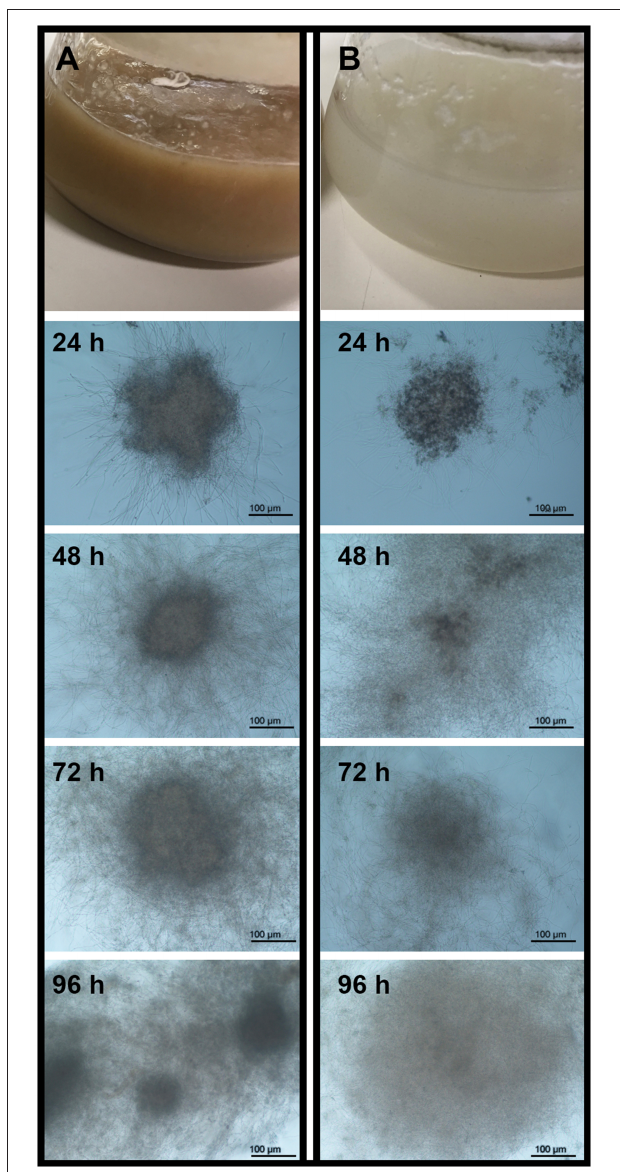
FIGURE 1 | Microsclerotia (A) and mycelial pellets (B) of Metarhizium robertsii ARSEF 2575 produced in submerged liquid medium. From top to bottom is shown: liquid cultures in Erlenmeyer flasks at the end of fermentation (96h), and the propagule formation registered at 100 × magnification with a light microscope at 24, 48, 72, and 96